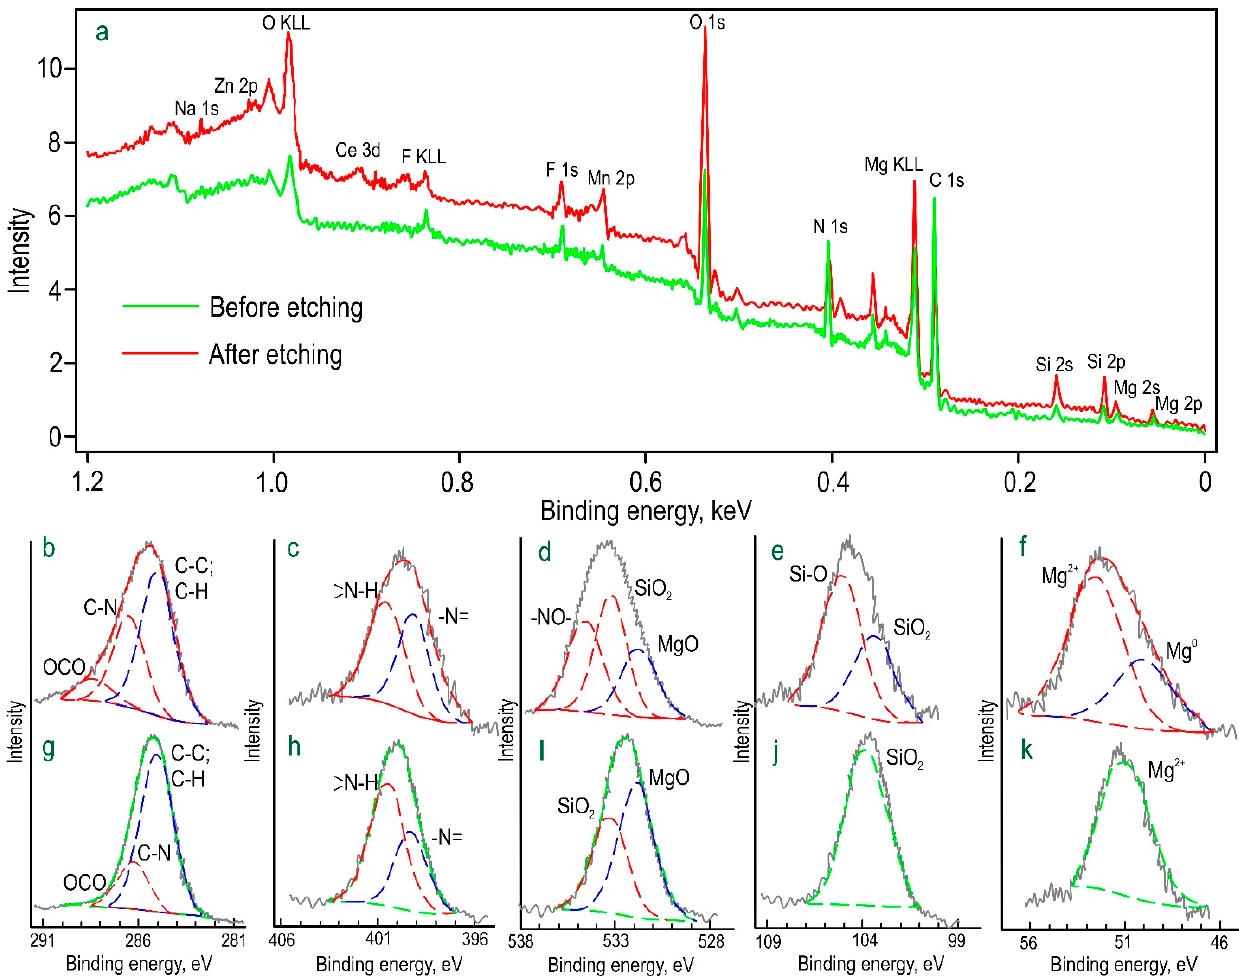
Figure 4. XPS spectra obtained for a sample with CC-0.1 coating ( a ). The detailed high-resolution spectra of C 1s ( b , g ), N 1s ( c , h ), O 1s ( d , i ), Si 2p ( e , j ), and Mg 2p ( f , k ) before ( g – k ) and after ( b – f ) Ar + etching. Table 2. Binding energy (eV) and elemental composition (at.%, in parentheses) of the sample’s sur- face after treatment of a PEO layer with benzotriazole (CC-0.1).